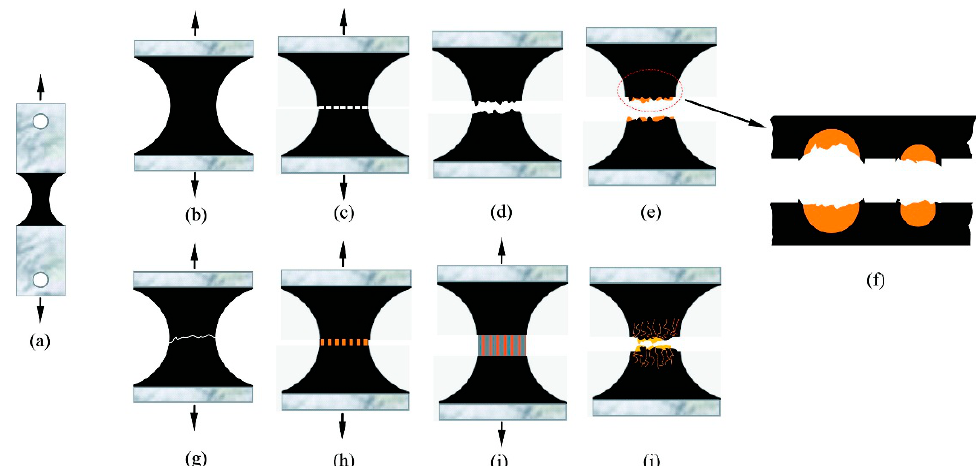
Figure 13. Illustration of self-healing of bitumen during tension test; ( a ) tension test sample; ( b – e ) the first-cycle of tension fracture; ( f ) the broken microcapsules on the interface of crack; ( g ) the healing process of bitumen sample; and ( h – j ) the second-cycle of tension fracture, rejuvenator penetration into aged bitumen.